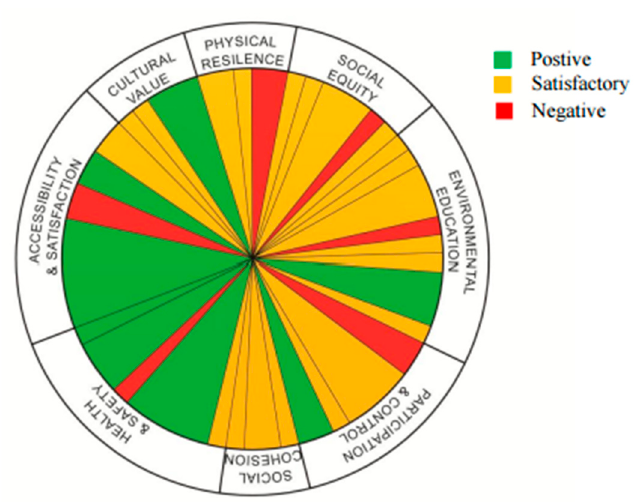
Figure 4. Sequence for identifying the objectives, target values and the impact of the indicators.